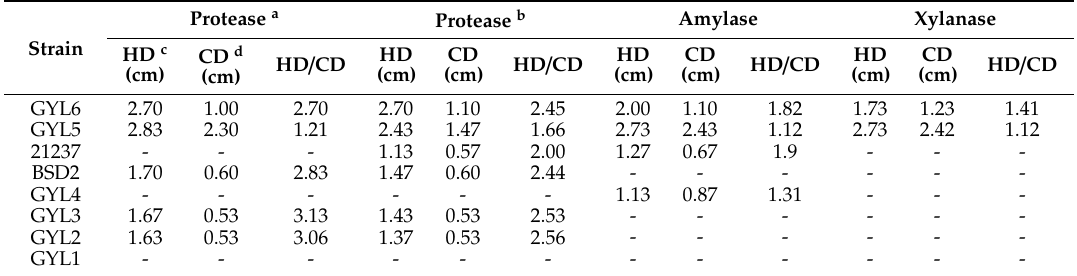
a Protease represents the ability of the strain to degrade glycinin; b Protease represents the ability of the strain to degrade β -conglycinin; c HD represents hydrolysis transparent zone diameter; d CD represents colony diameter. - represents no detection.